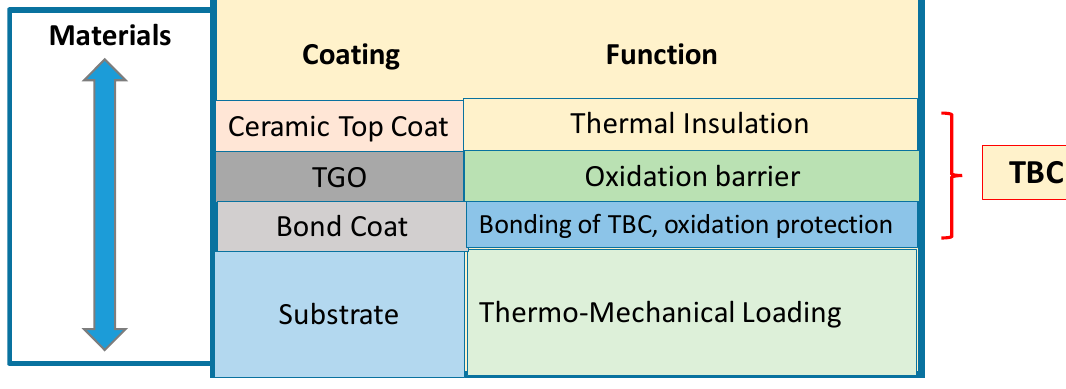
Figure 4. Scheme of coating construction of TBC barrier layers and the roles of the individual sublayers.